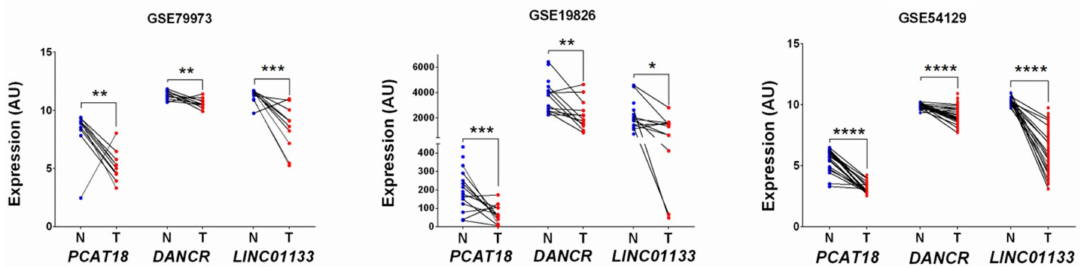
Figure 2. PCAT18 , DANCR , and LINC01133 expression levels in GC and adjacent normal tissues. Expression data were retrieved from the GEO datasets ( A ) GSE79973, ( B ) GSE19826, and ( C ) GSE54129. N, normal tissue (blue dots); T, tumor tissue (red dots); AU, arbitrary unit. * p ≤ 0.05, ** p ≤ 0.01, *** p ≤ 0.001, **** p ≤